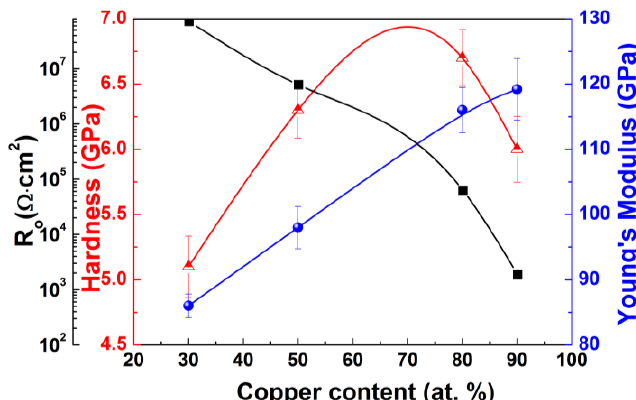
Figure 9. Composition dependence on mechanical properties and R ct value of the Zr-Cu glassy coatings.